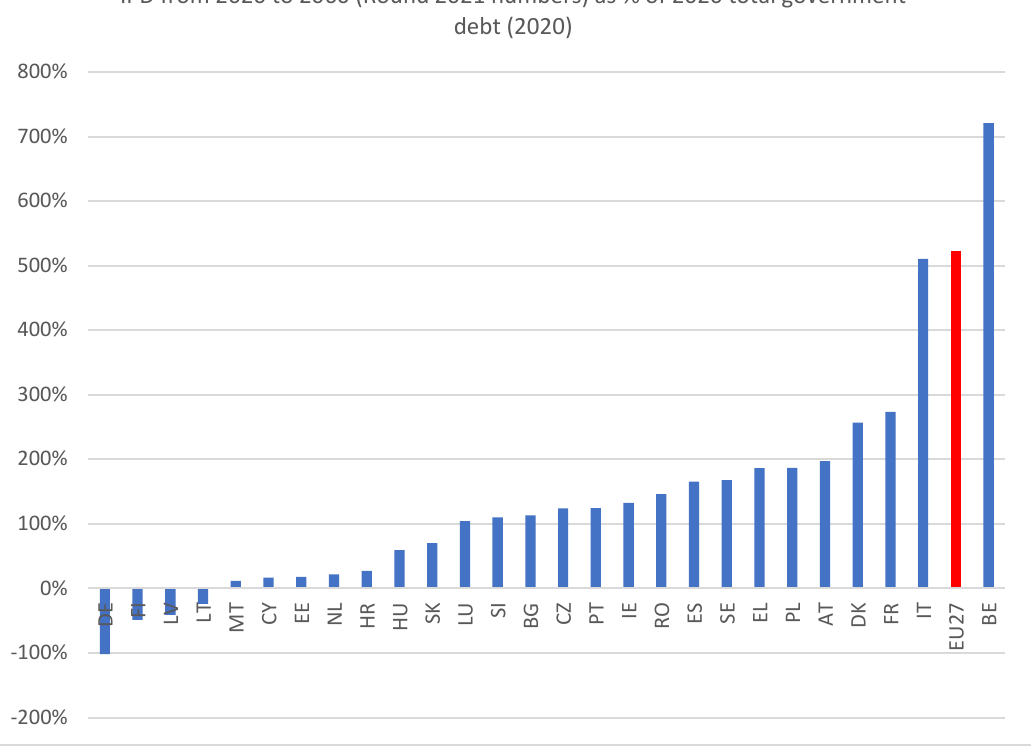
Figure 3. IPD 2020–2060 as percentage of total government debt of 31/12/19. Source: Authors’ calculations and (Eurostat 2021).